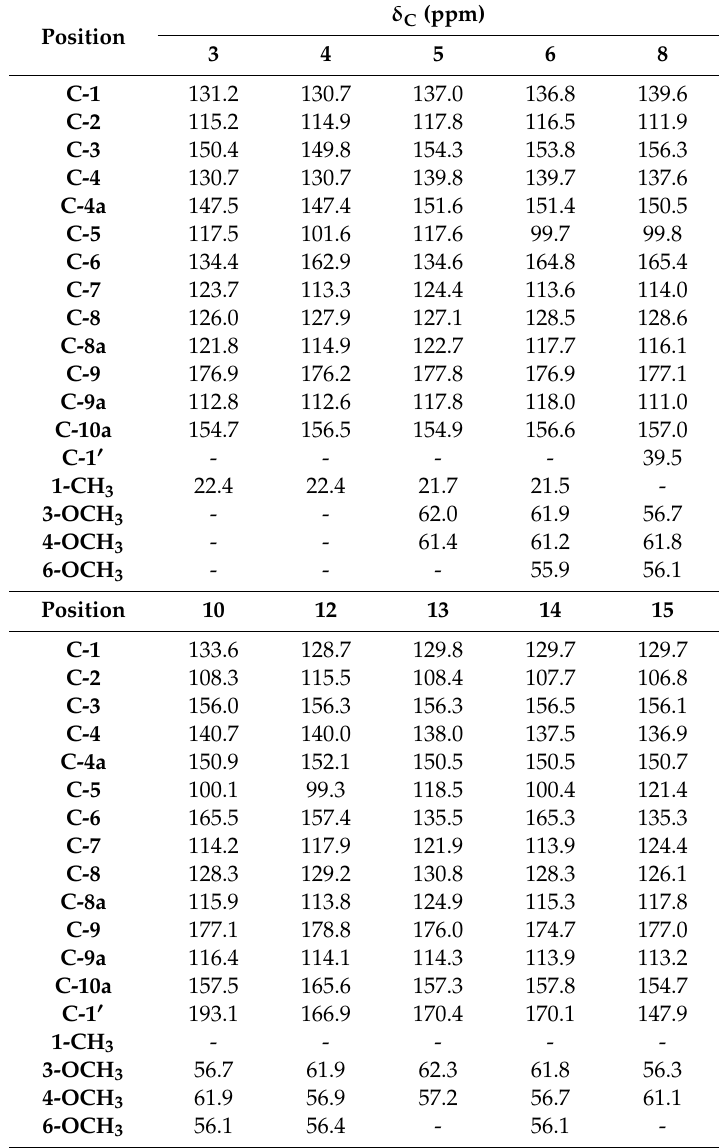
Table 2. 13 C-NMR data (75 MHz, CDCl 3 ) for 3 – 6 , 8 , 10 – 15